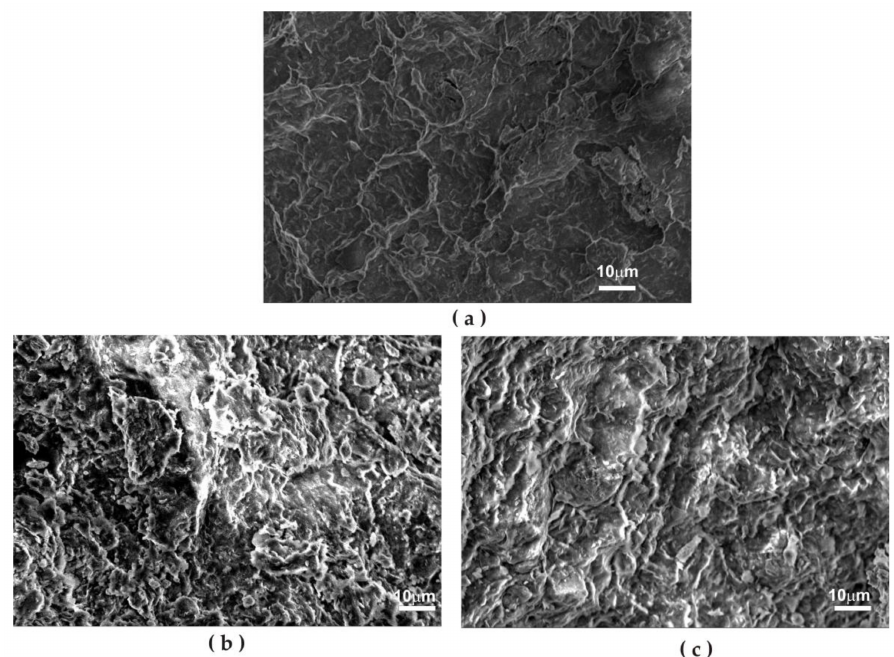
Figure 14. Change of fabric caused by porewater replacement: ( a ) initial freshwater clay fabric; ( b ) parallel fabric after porewater replacement with 1000 mg/L NaCl solution; ( c ) denser parallel fabric after porewater replacement with 6000 mg/L NaCl solution.